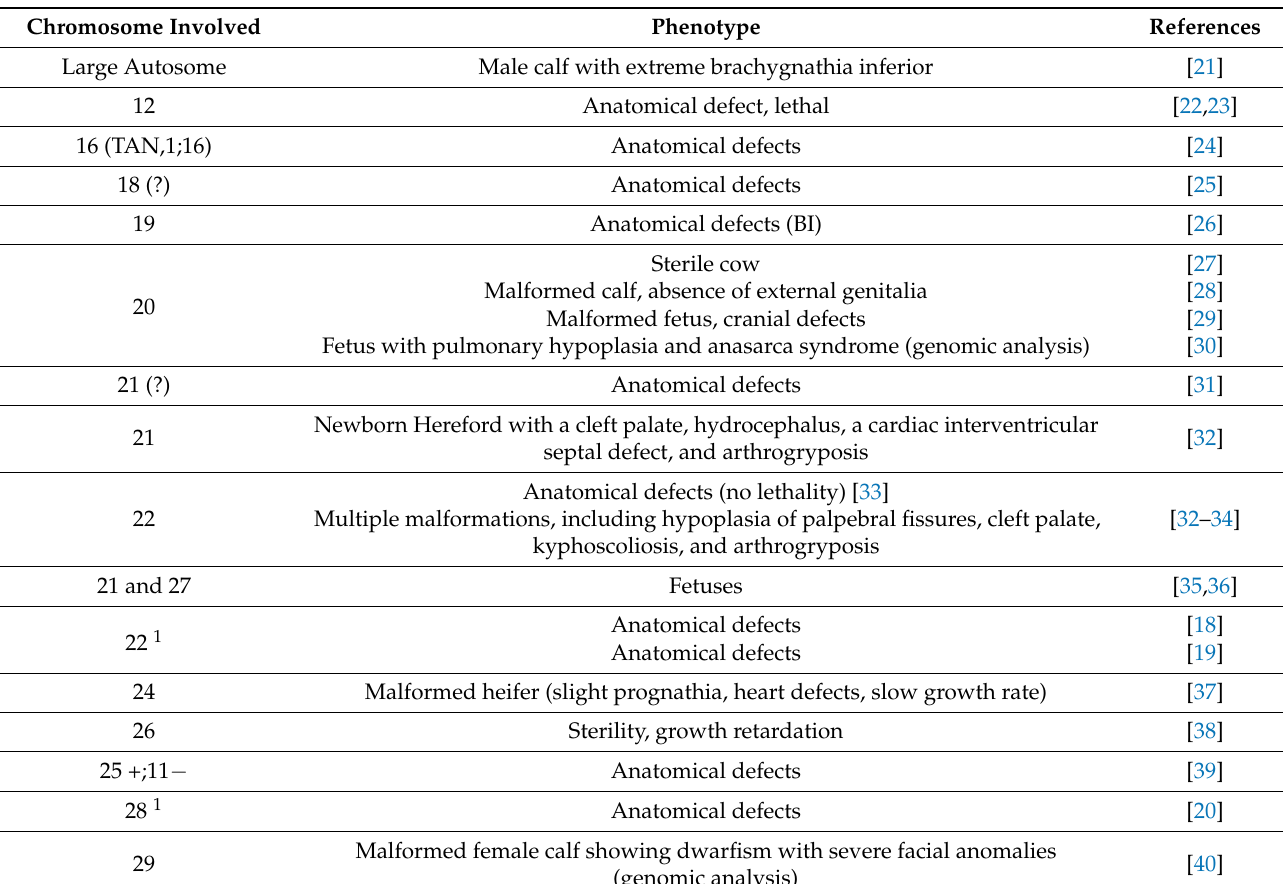
Table 2. Autosomal trisomies in cattle.